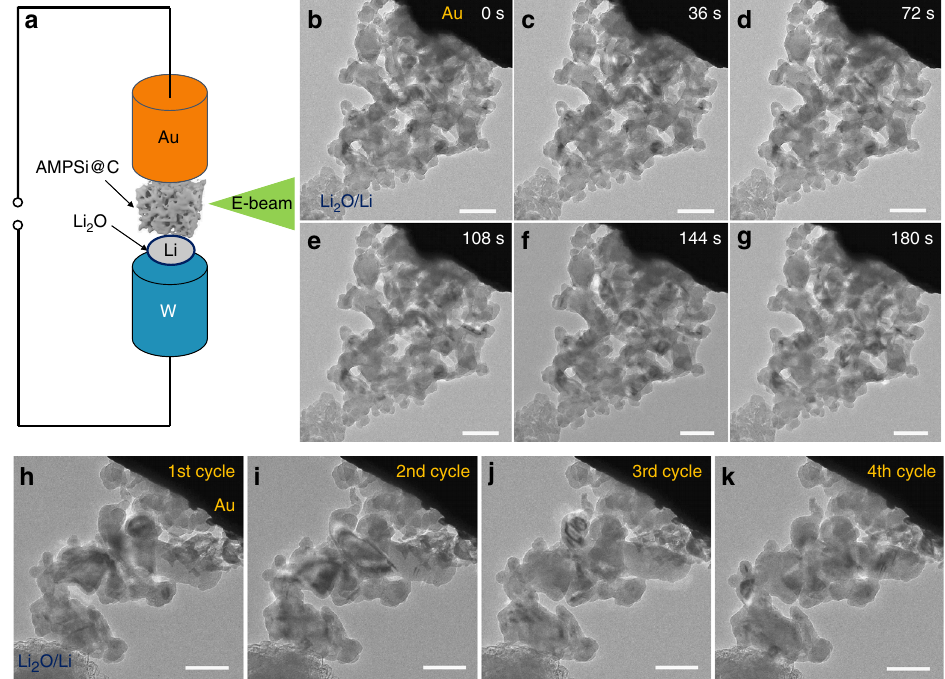
Fig. 6 In situ lithiation/delithiation behavior of AMPSi@C. a Schematic of in situ nanobattery con fi guration. b – g Time-resolved TEM images depicting the lithiation process of AMPSi@C electrode (Supplementary Movie 1). After full lithiation, AMPSi@C exhibits inward expansion and does not show cracks